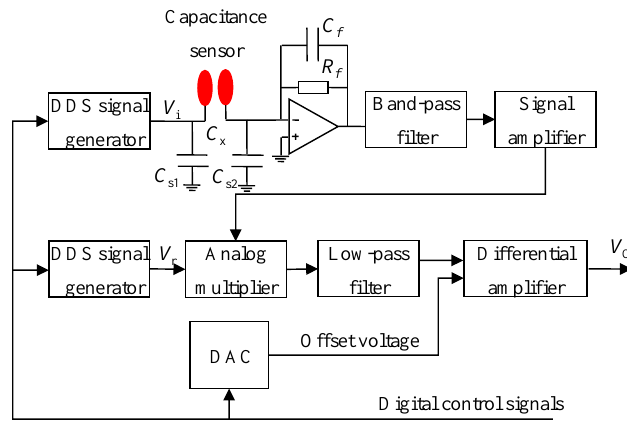
Figure 3. Charge to voltage conversion (E/V) circuit.